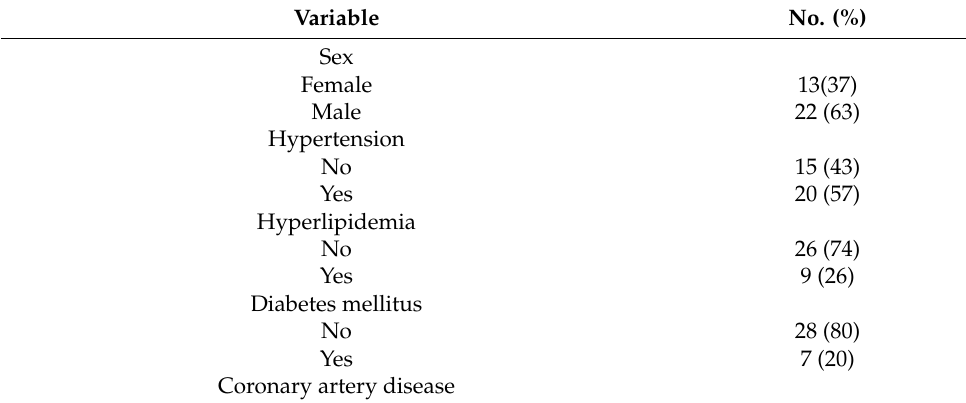
Table 1. Baseline (i.e., at diagnosis of acute interstitial nephritis) demographic and clinical character- istics of patients who developed acute interstitial nephritis after treatment with immune checkpoint inhibitors (n =